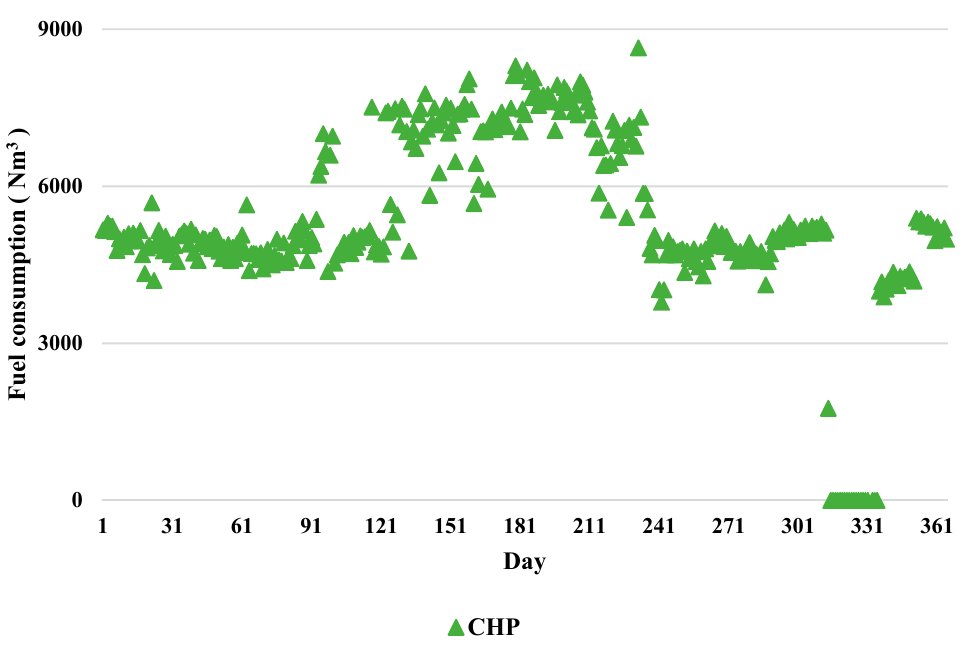
Figure 10. Annual daily profile for the power supply and demand for Case C.